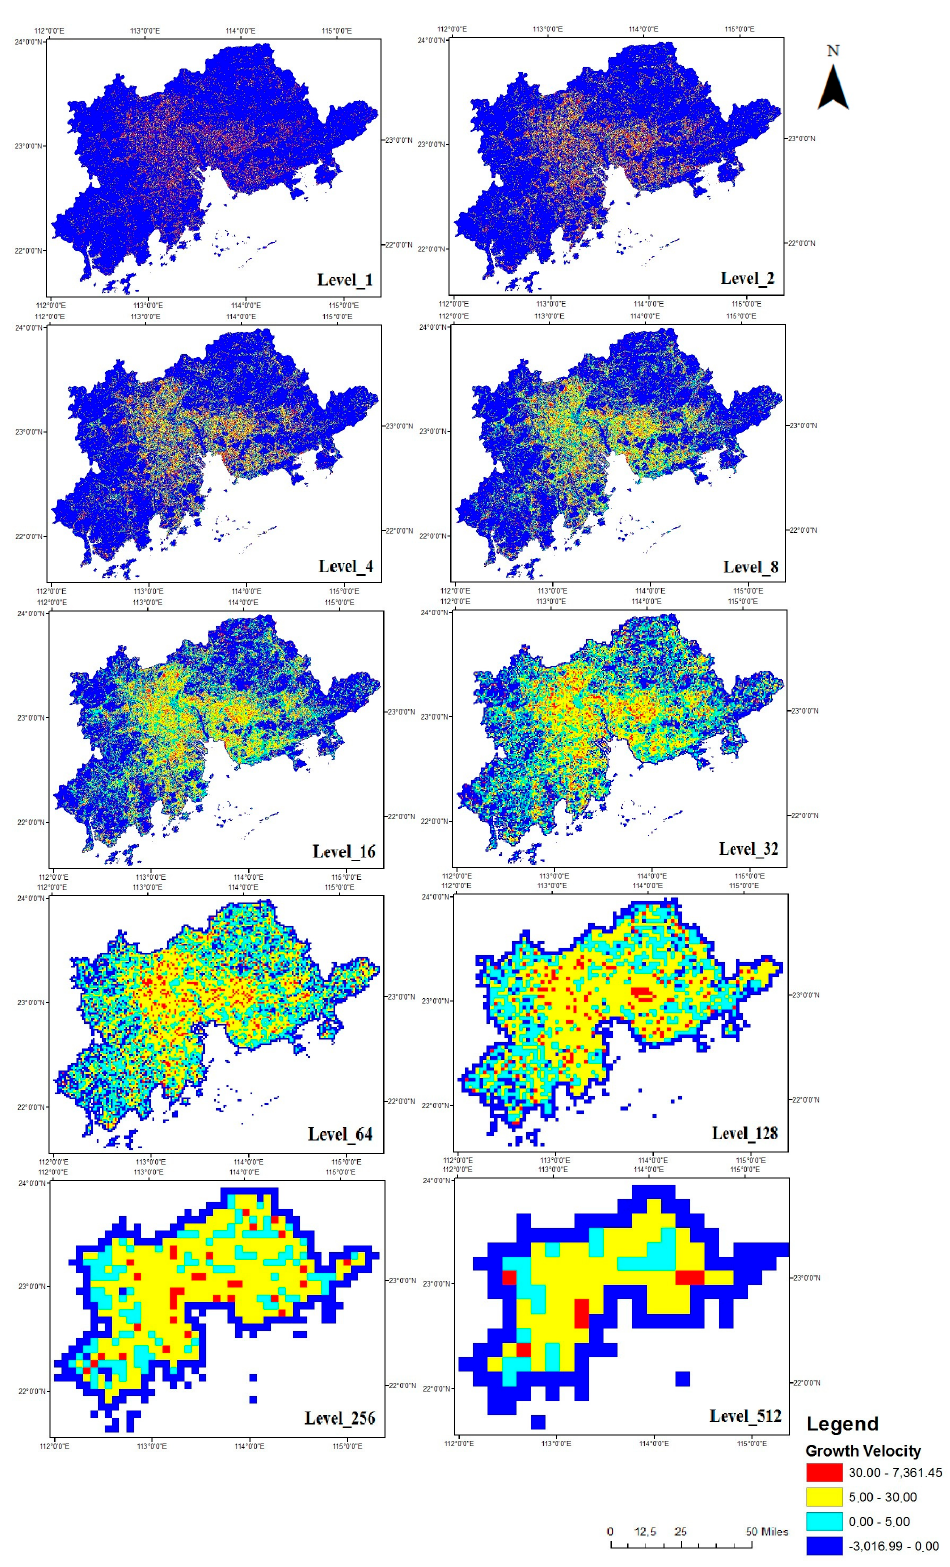
Figure 5. Urban growth velocities in the Pearl River Delta for the years 2000 to 2015.